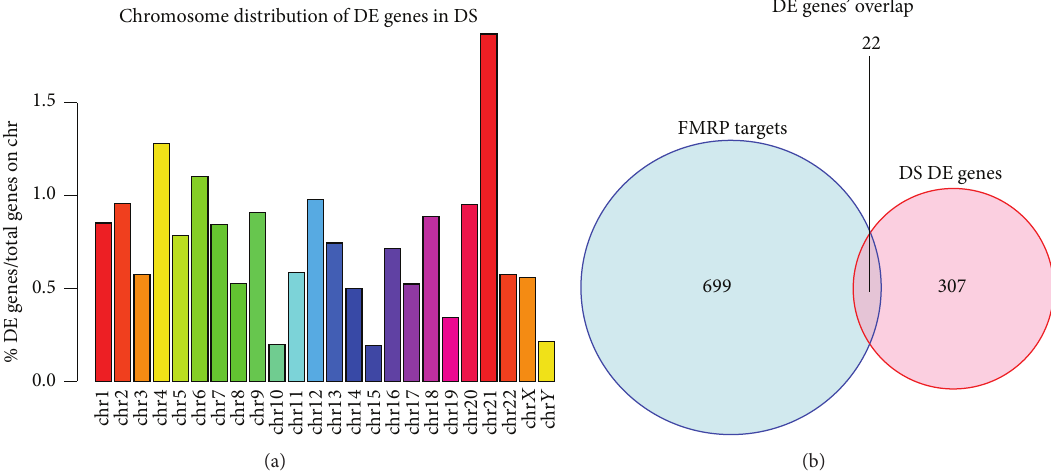
Figure 3: Differentially expressed (DE) genes in Down Syndrome (DS). (a) Bar plot showing the percentage of differentially expressed (DE) genes in DS over the total genes of each chromosome. (b) Venn Diagram showing the overlap among FMRP targets and a list of genes consistently expressed differentially in